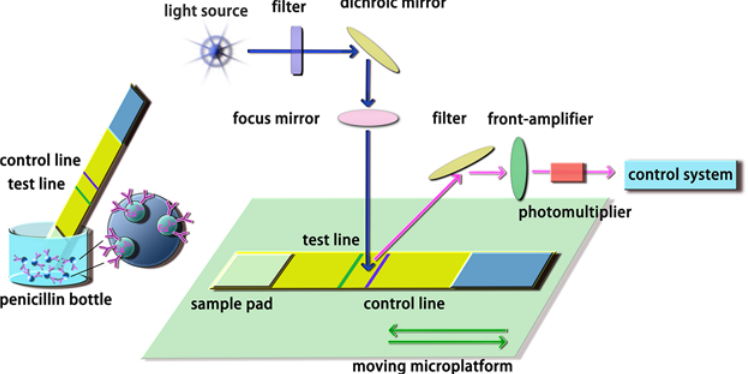
Fig 1. Schematic illustration of the CTRFIA sensing platform for determination of AFB 1 in food and feed.